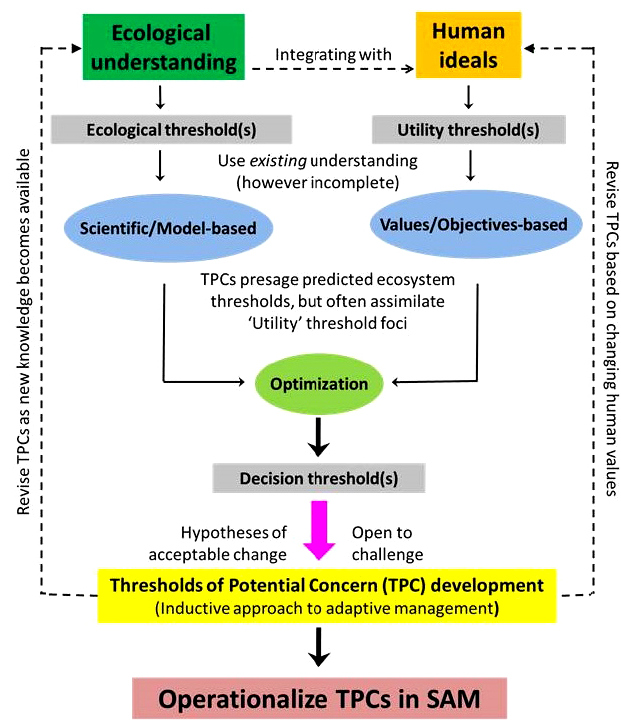
understanding associated with human ideals).